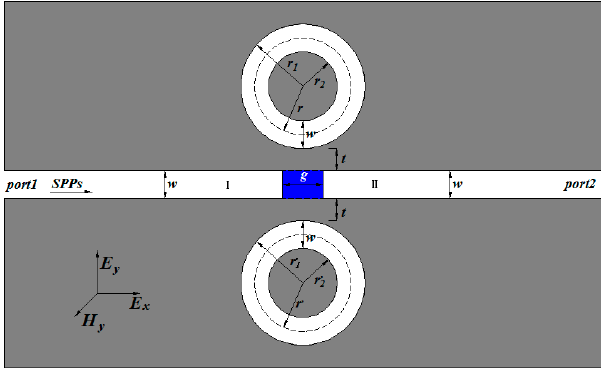
Figure 1. Schematic of the structure composed of two shunt-wound rings resonators with two waveguides and the structure parameters are w = 50 nm, g = 20 nm, and t = 10 nm.